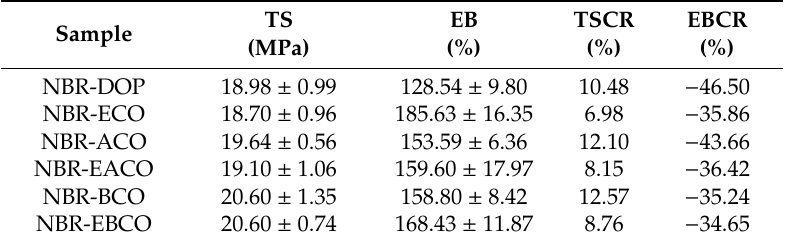
Figure 4. The change in hardness, mass, and volume of NBR vulcanizates after hot air aging. Table 4. The mechanical properties of NBR vulcanizates after hot air aging.